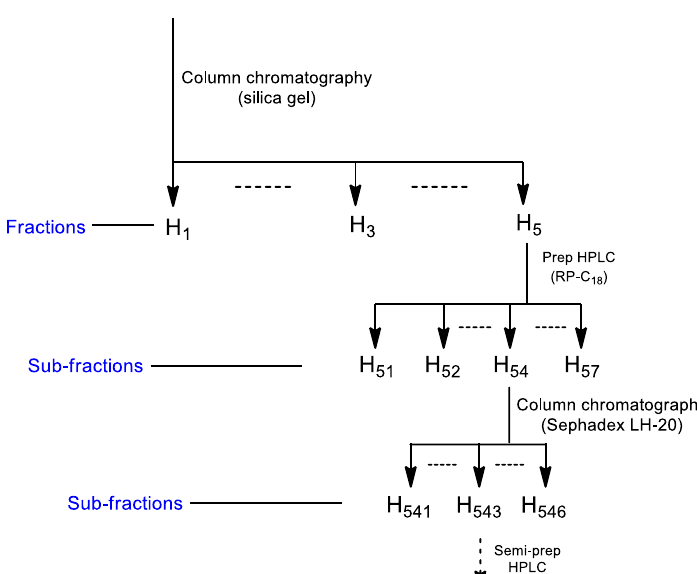
Figure 3. Chemical structures of compounds 1 – 5 .